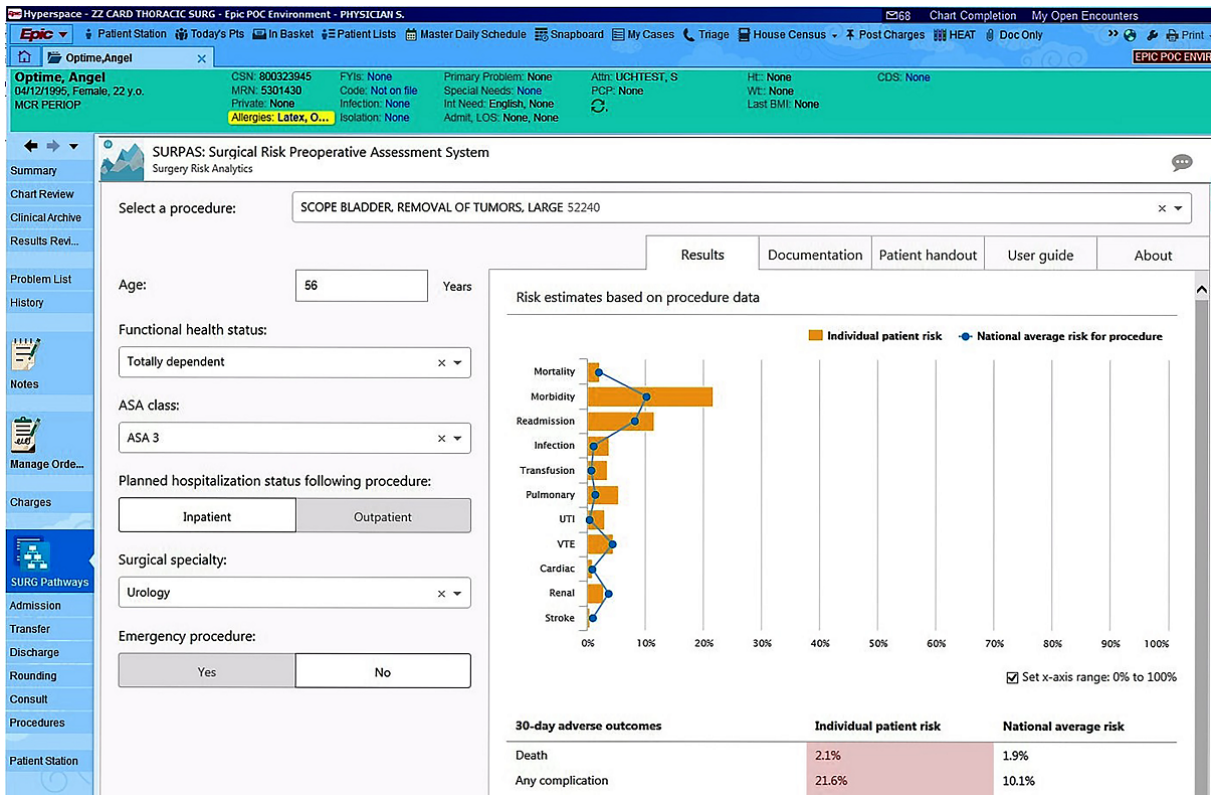
Figure 2. Screenshot of the Surgical Risk Preoperative Assessment System, a personalized risk assessment clinical decision support application used to guide postoperative care, with synthetic patient